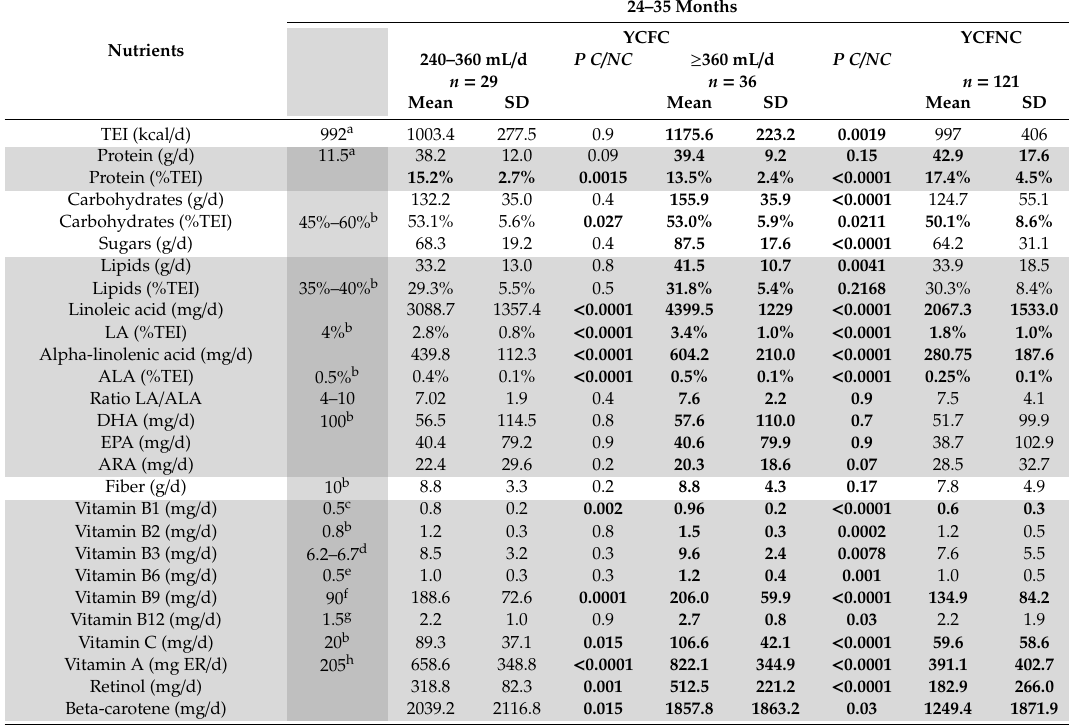
Table 8. Daily nutrient intake of YCF-C compared to YCF-NC aged 24–36 months, according to the intake of formula consumed and to EFSA DRVs, AR, or AI.